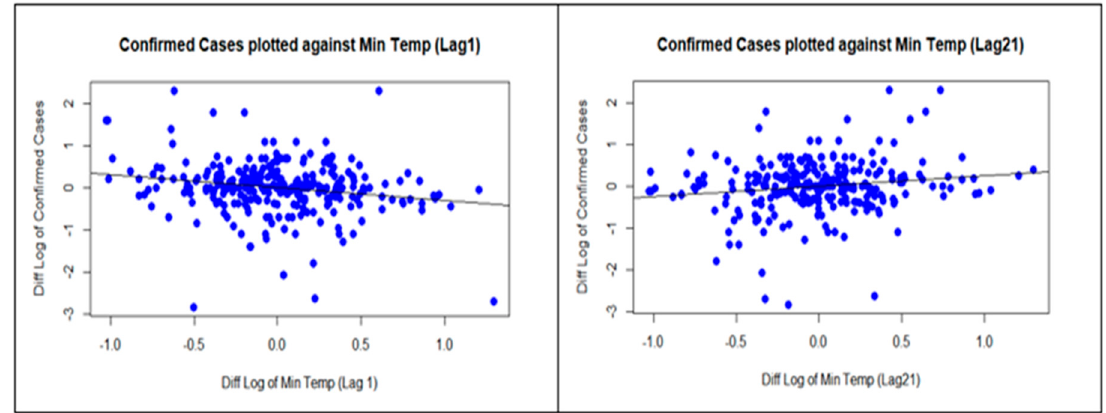
Figure 6. Scatterplots of confirmed cases and minimum temperature at Lag 1 and 21 days.